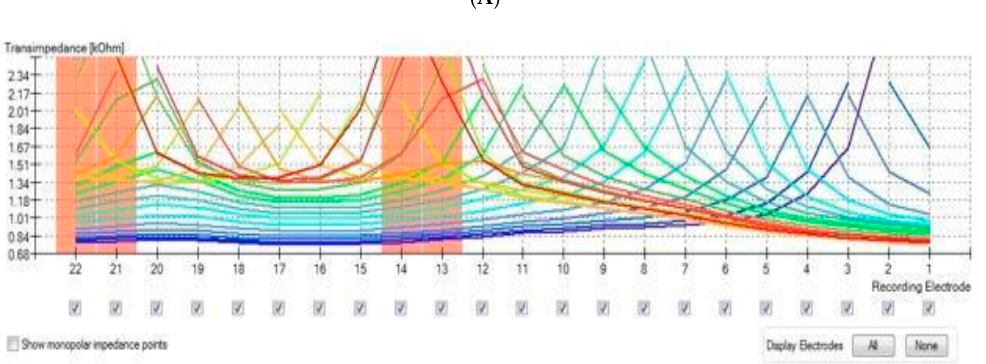
Figure 3. ( A ) Electrode fold ‐ over presented on a heat map. The global maximum value is the stimulating electrode, but another local maximum will appear indicating fold ‐ over. ( B ) Electrode fold ‐ over presented on a line graph.